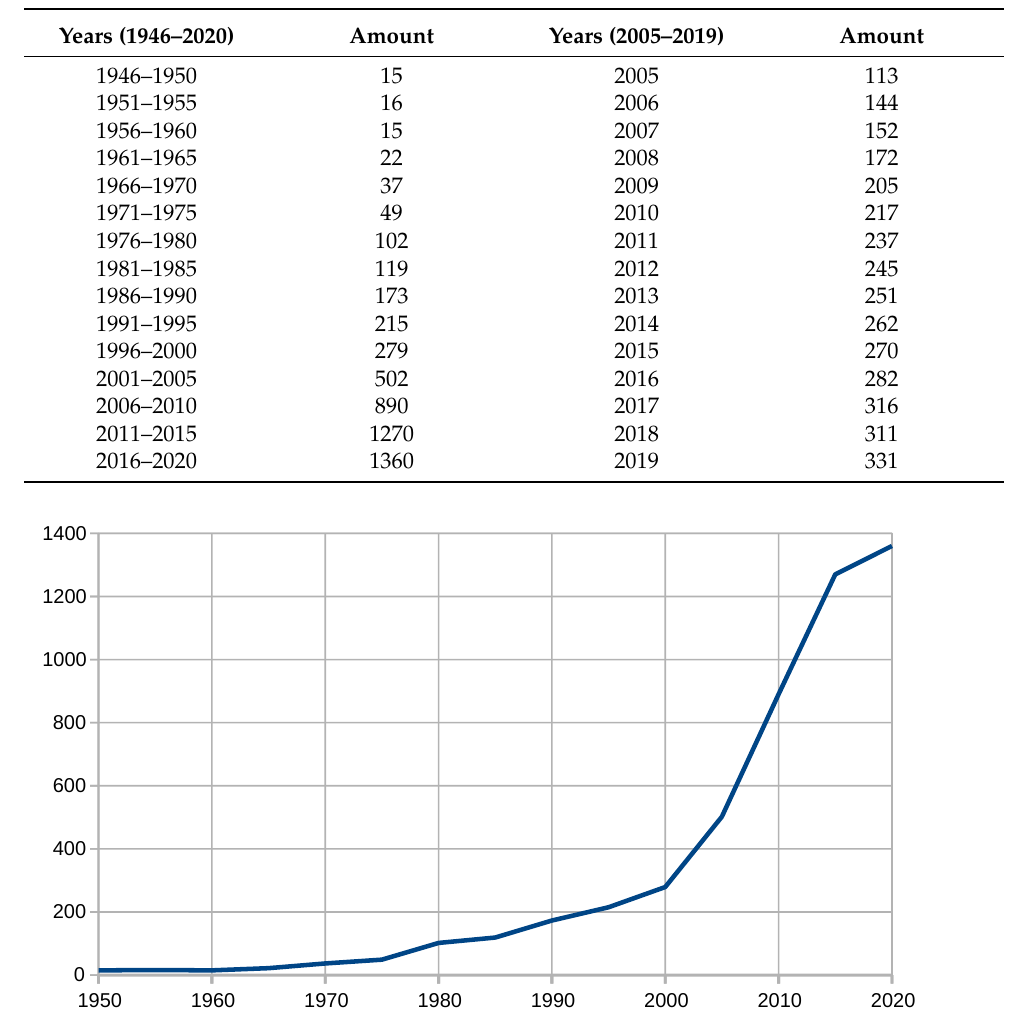
Table 1. Number of publications on insect radar according to Google Scholar.